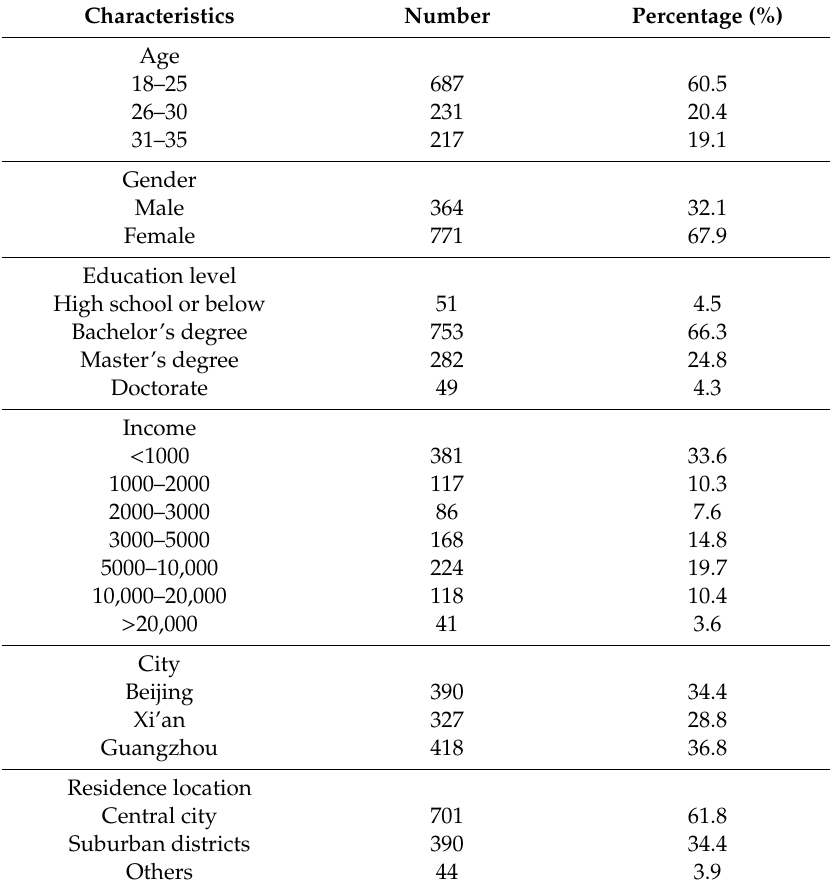
Table 2. Demographic characteristics of participants (N =